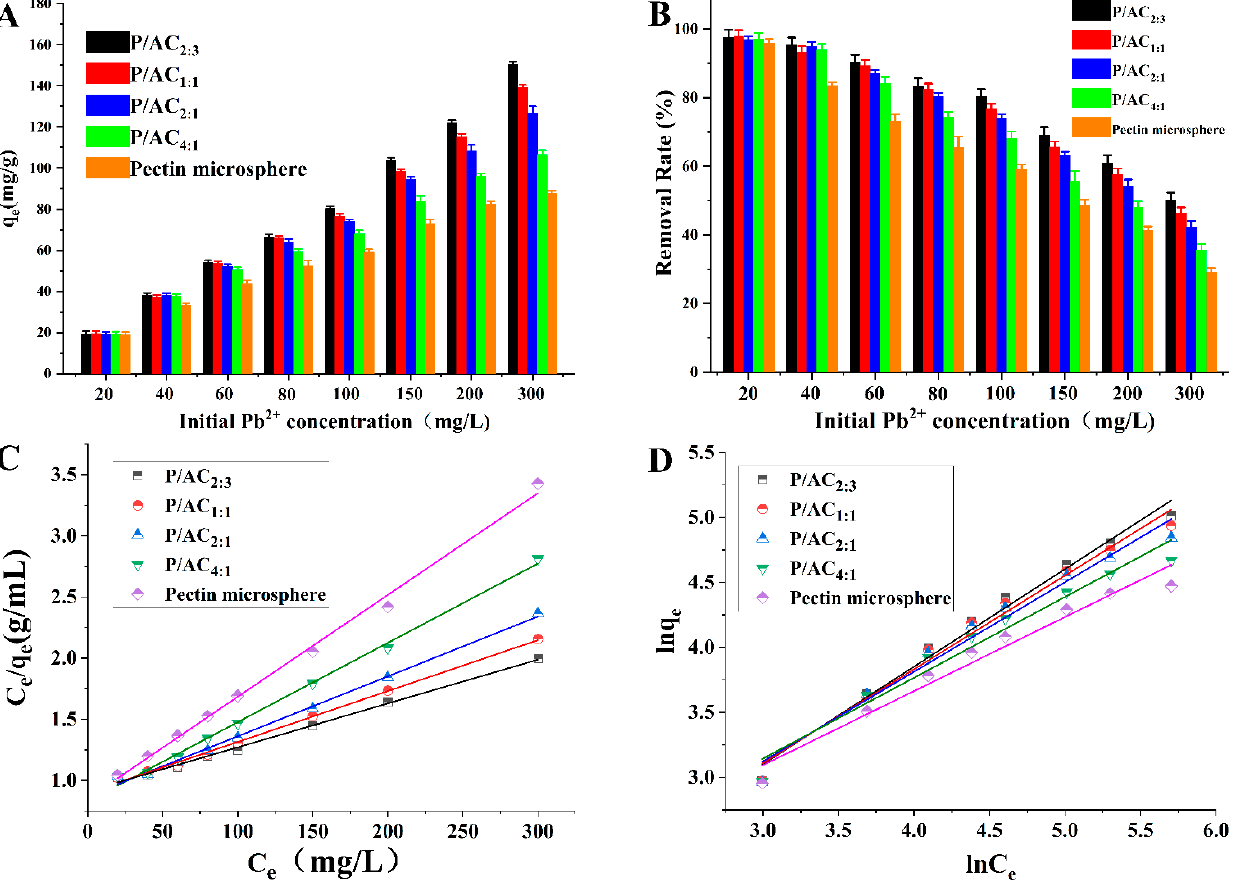
Figure 6. The effect of initial Pb 2+ concentration (20, 40, 60, 80, 100, 150, 200, and 300 mg/L) on adsorption capacity ( A ) and removal rate ( B ) of P/ACs towards Pb 2+ . Adsorption isotherms for Pb 2+ according to Langmuir model ( C ) and Freundlich model ( D ) (adsorbent dosage of 1.0 g/L, solution pH of 5.0, temperature of 298 K, contact time of 1440 min). Table 3. Isotherm parameters, correlation coefficients for adsorption of Pb 2+ by P/ACs, and original pectin